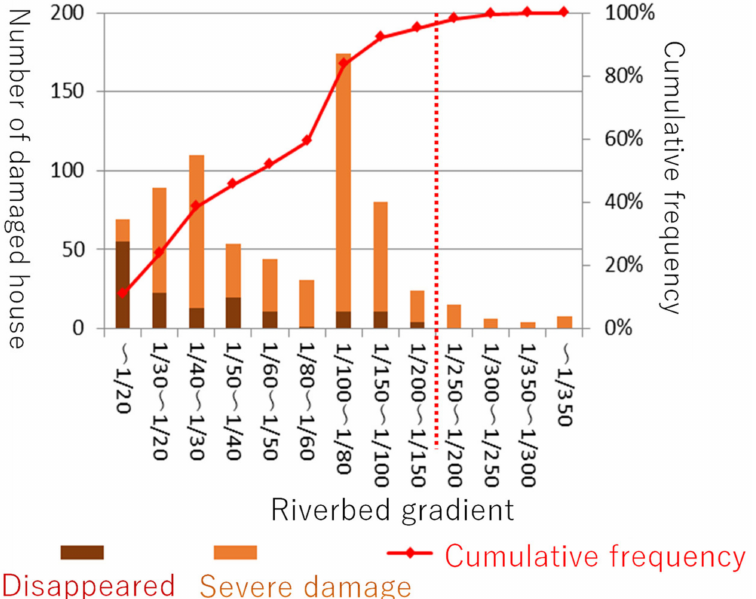
Figure 6. Relationships between characteristics of damaged houses and river gradient (cited from Sakai et al., 2021